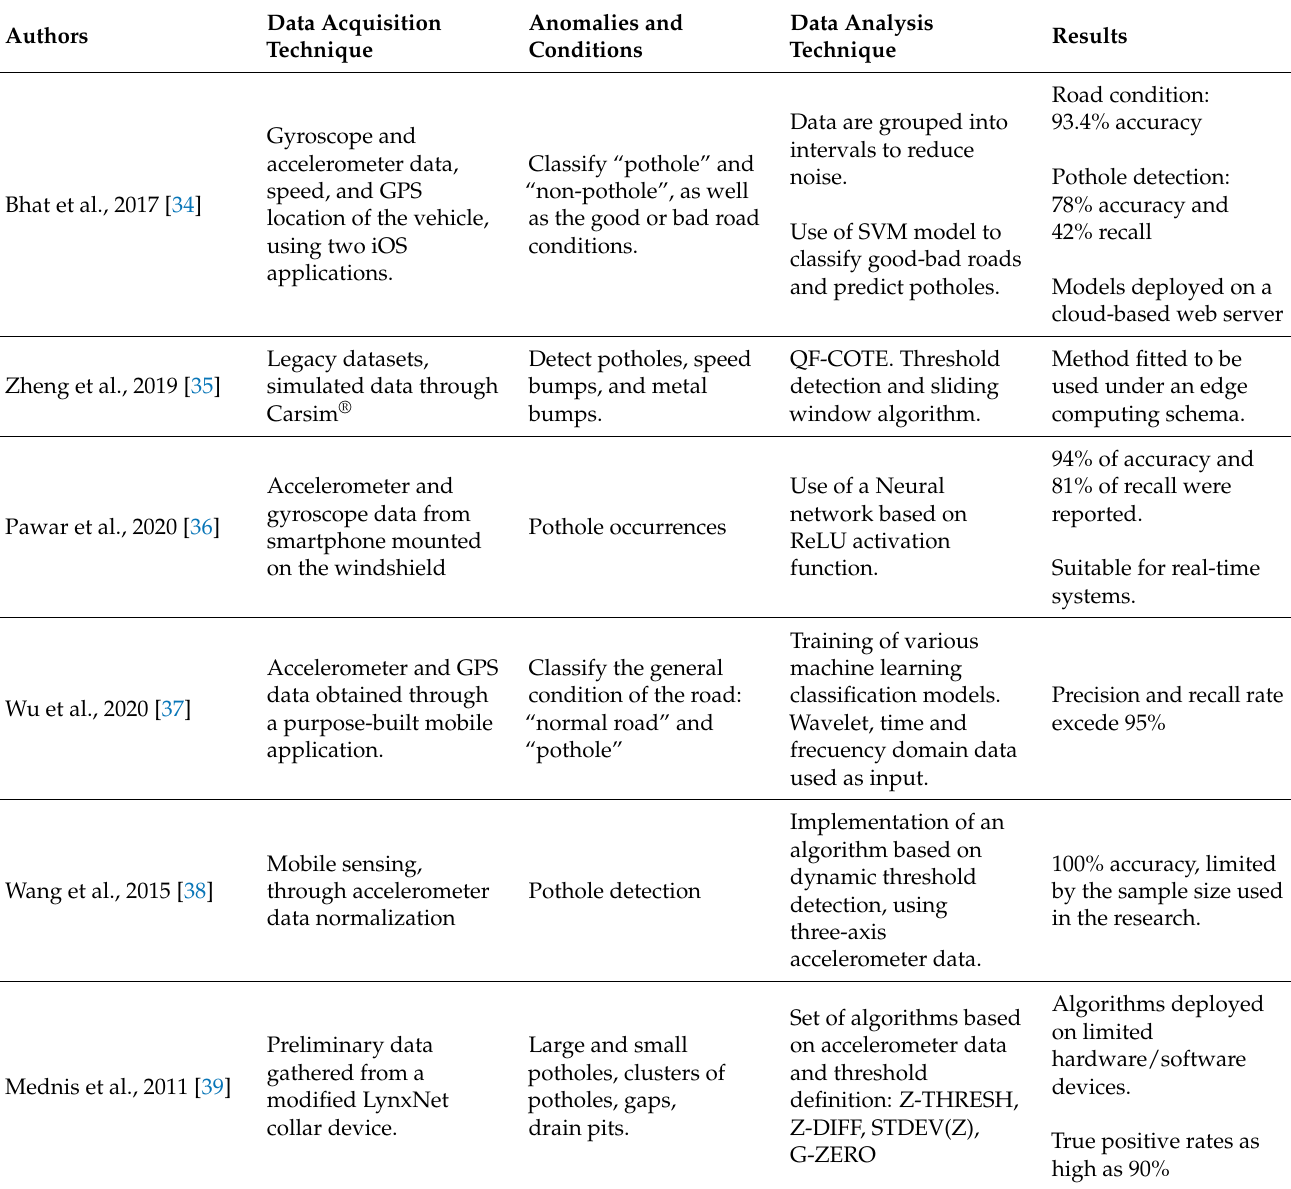
Table 2. Main research approaches for the detection of road